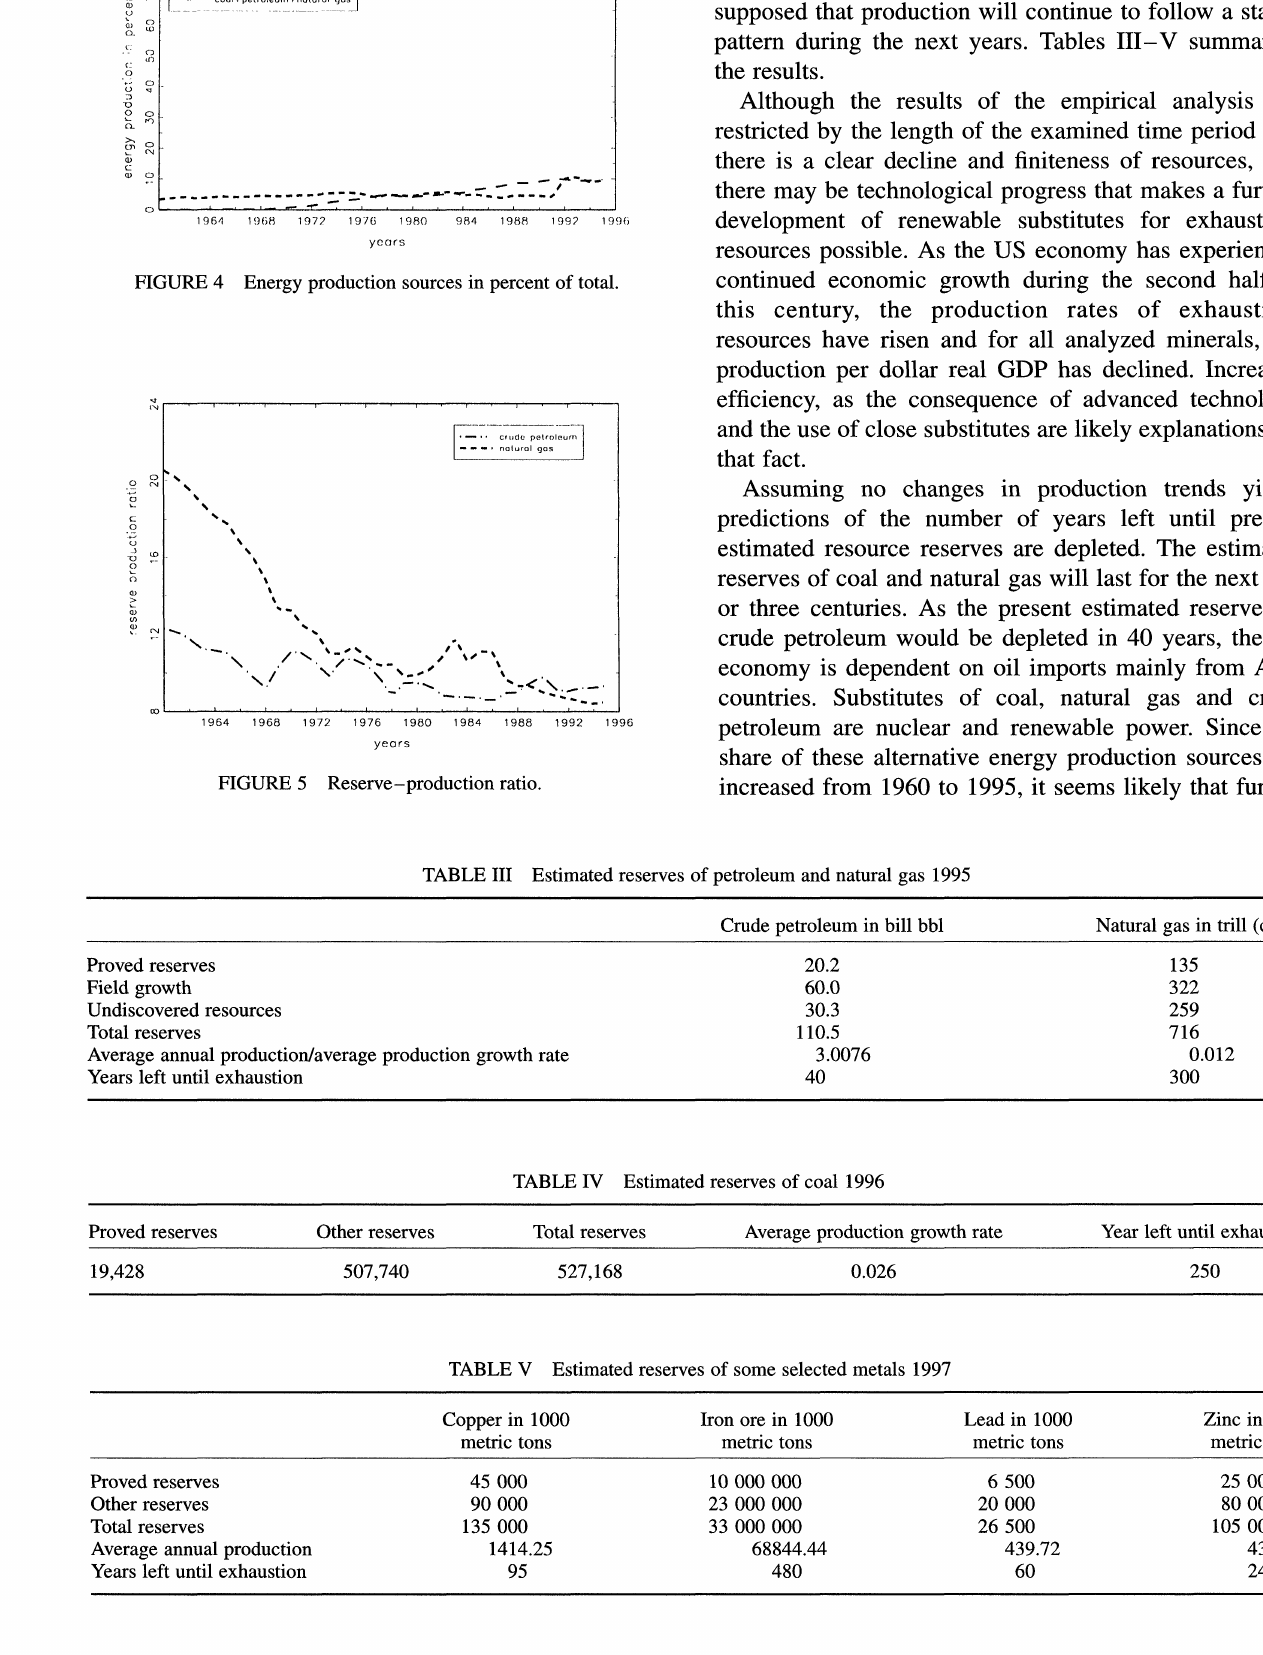
FIGURE 4 Energy production sources in percent of total.